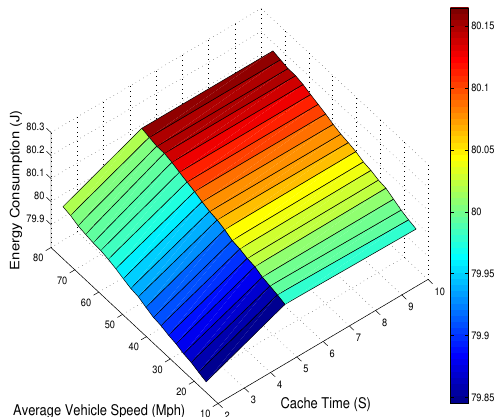
Figure 10. Number of dropped packets vs. 2 s, 5 s, 10 s Cache Time and Average Vehicle Speed (Mph).